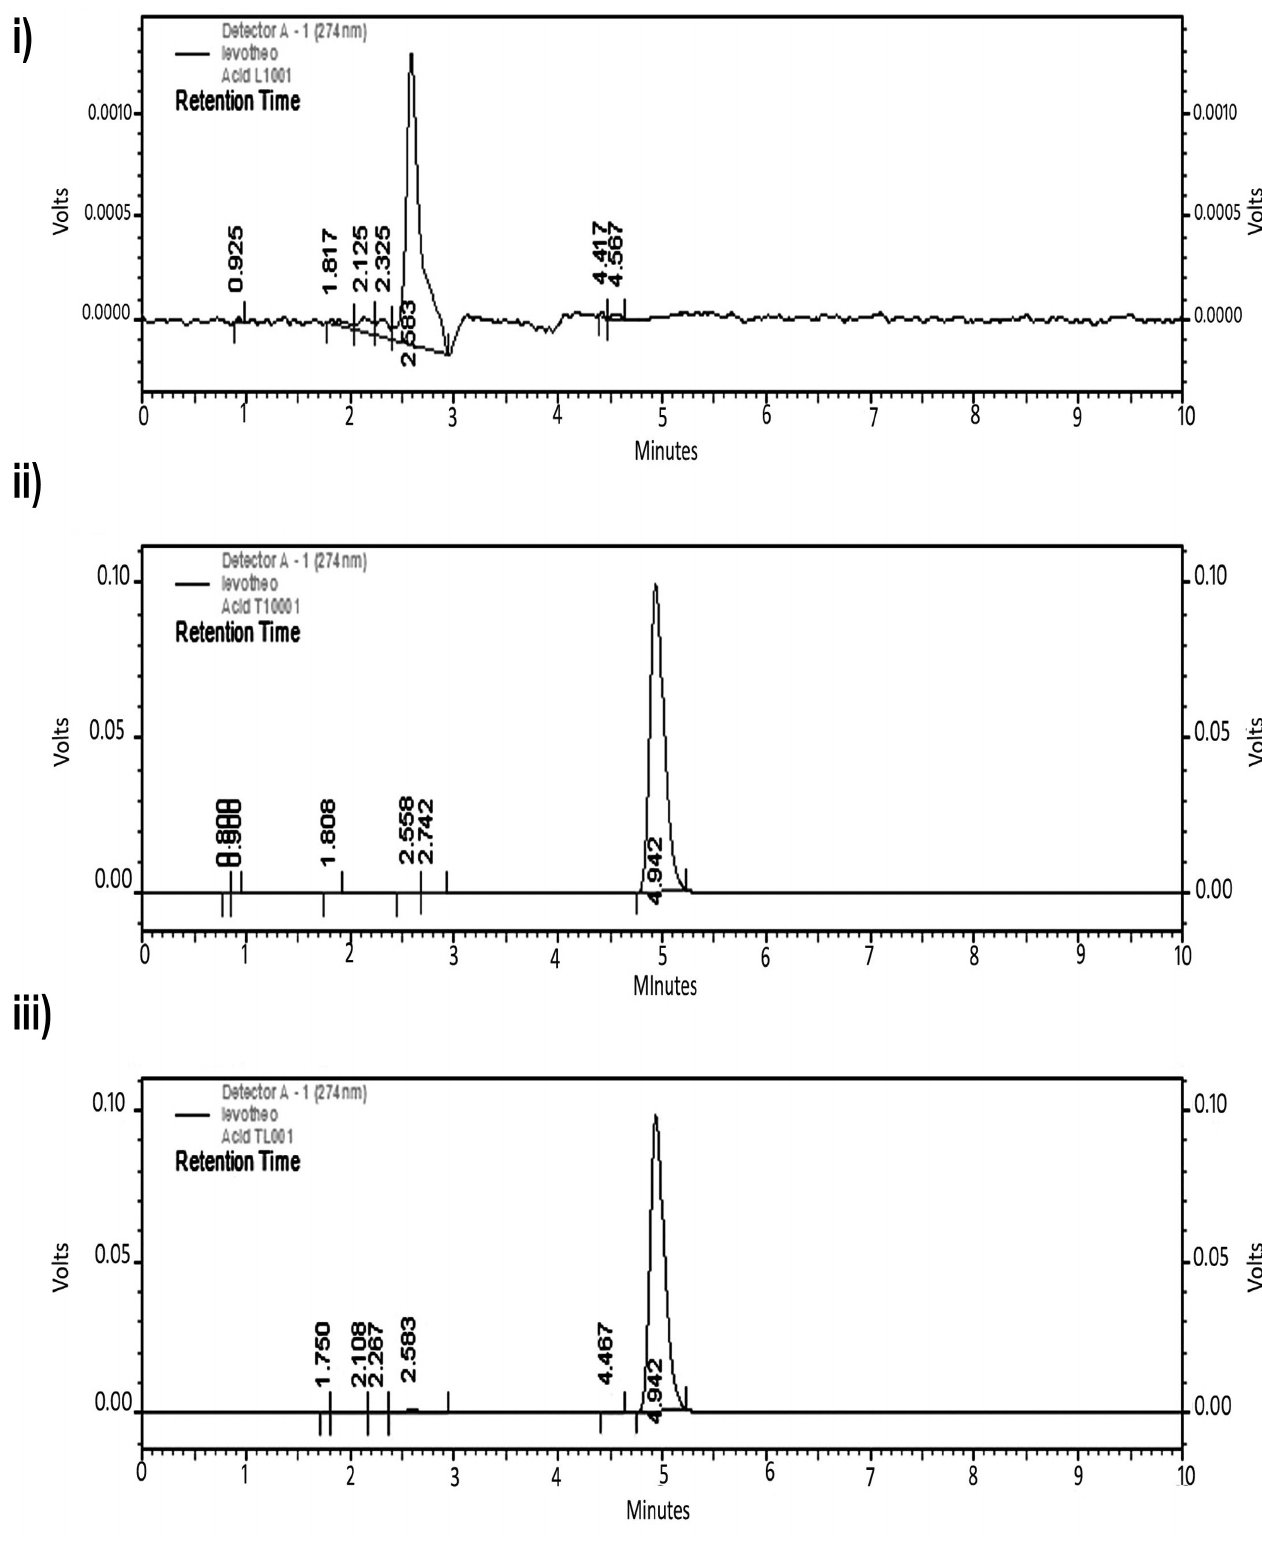
FIGURE 3B - Representative chromatograms of acid degraded drugs. Each chromatogram represents (i) levosalbutamol sulfate (1 μg. mL -1 ), (ii) theophylline (10 μg .mL -1 ), (iii) dosage form having levosalbutamol sulfate (1 μg. mL -1 ) and theophylline (10 μg. mL -1